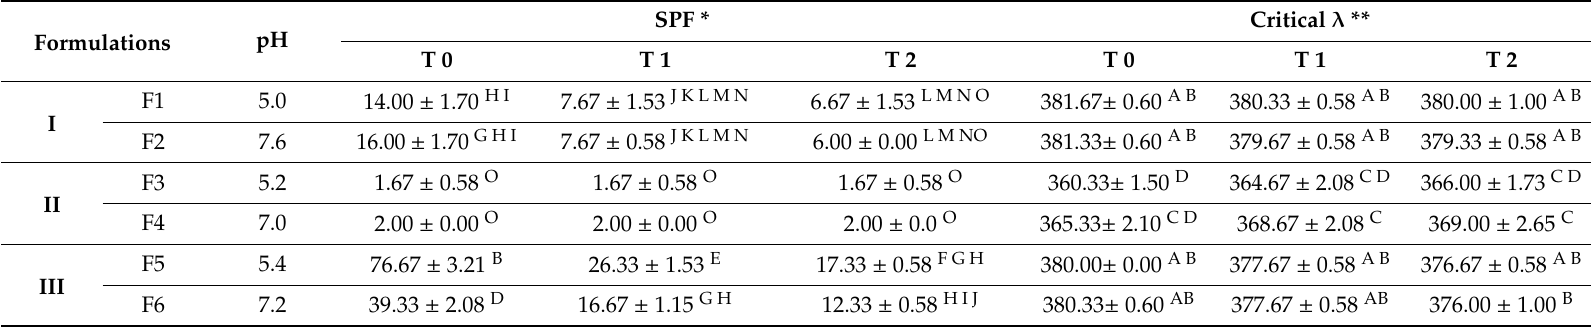
Table 3. In vitro SPF and critical wavelength (nm) values of sunscreens at di ff erent pH values and irradiation times.